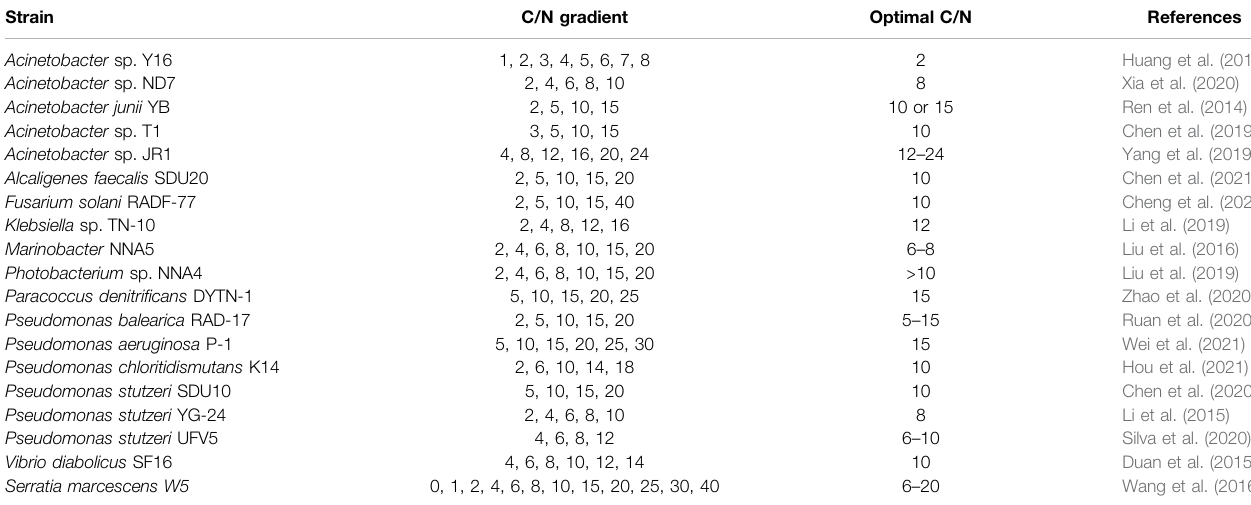
TABLE 4 | Ranges of C/N for